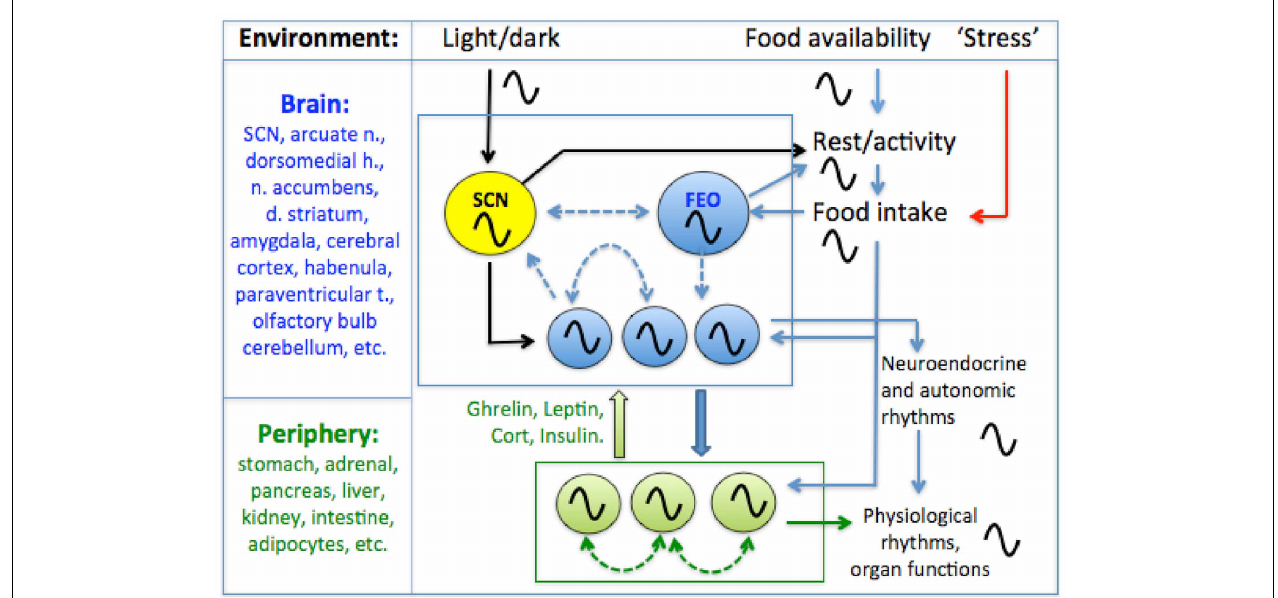
FIGURE 1 | A conceptual model of the mammalian circadian system. A circadian pacemaker located in the retinorecipient suprachiasmatic nucleus (SCN) in the hypothalamus generates circadian rest-activity, feeding, body temperature and other rhythms that entrain to environmental light-dark (LD) cycles. The daily feeding rhythm provides time cues that entrain circadian oscillators elsewhere in the brain and in most peripheral organs and tissues. Limiting food access to a single daily meal entrains central and peripheral oscillators, decoupling these from the SCN pacemaker which remains entrained to LD. Some SCN-independent food-entrainable oscillators (FEOs)